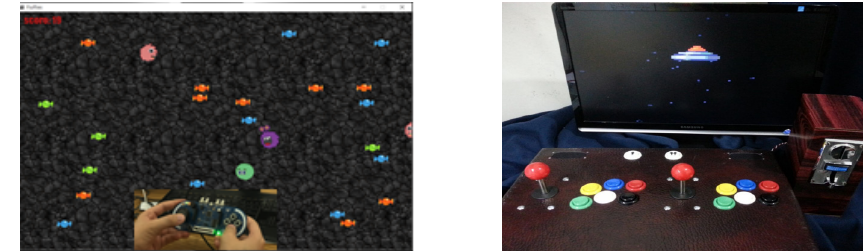
Fig. 3. A game of fluffies and Arcduino (An Arduino-based arcade